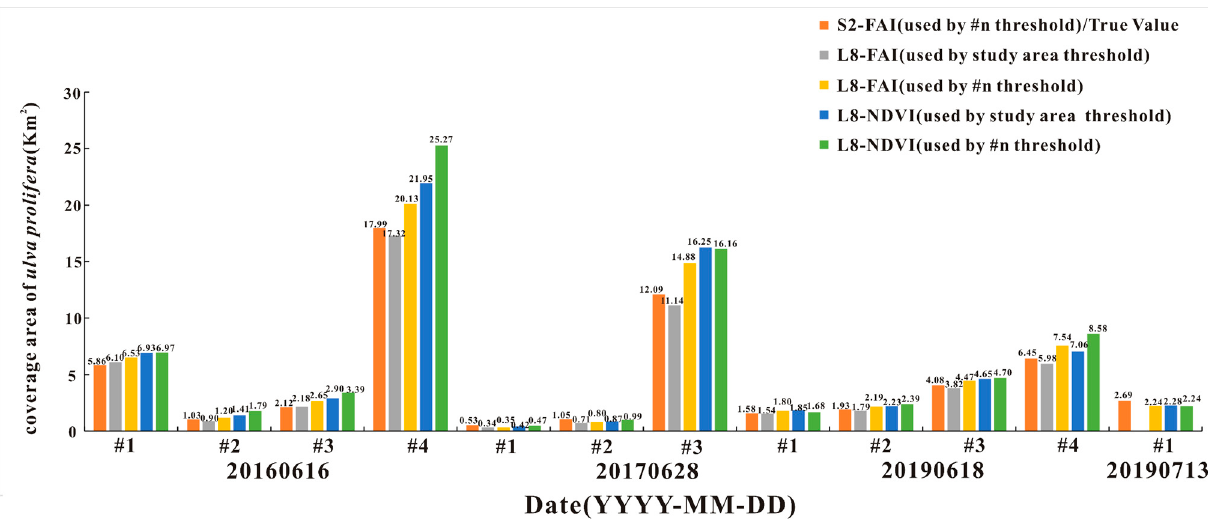
Figure 14. Statistical map of U. prolifera area. “S2” represents Sentinel-2/MSI images, “L8” represents Landsat8/OLI images, “used by #n threshold” represents the area of U. prolifera based on the threshold of the n -th ROI, n = 1, 2, 3, 4, “used by study area threshold” represents the area of U. prolifera based on the threshold of the whole study area.